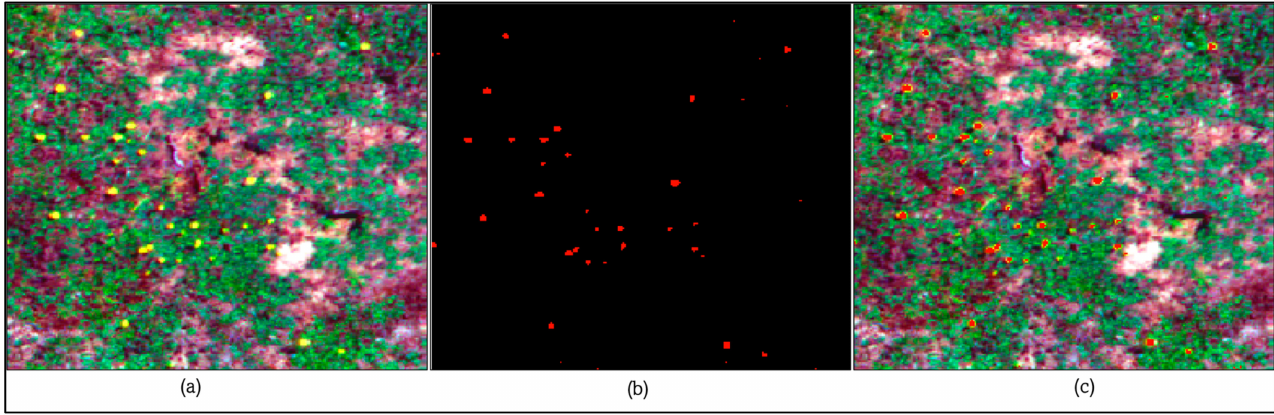
Figure 10. Validation at ground truth location number 11 ( a ) Actual multispectral image; ( b ) Predic- tion result; ( c ) Prediction results are overlayed with actual image (EPSG:4326—WGS